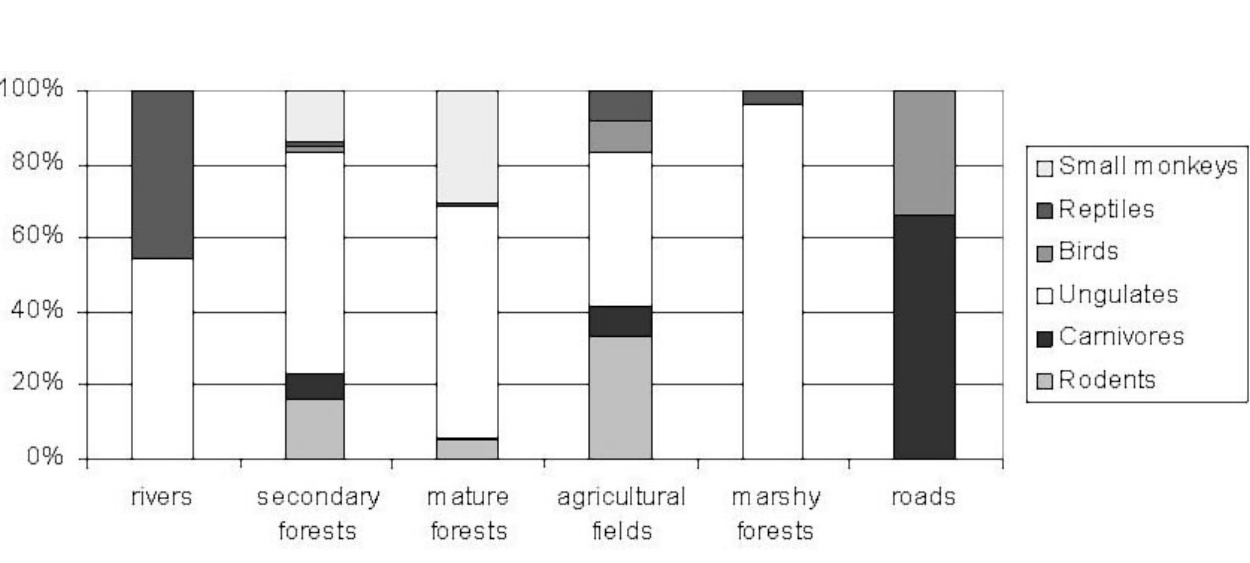
Fig. 4. Types of animals killed in each habitat type in